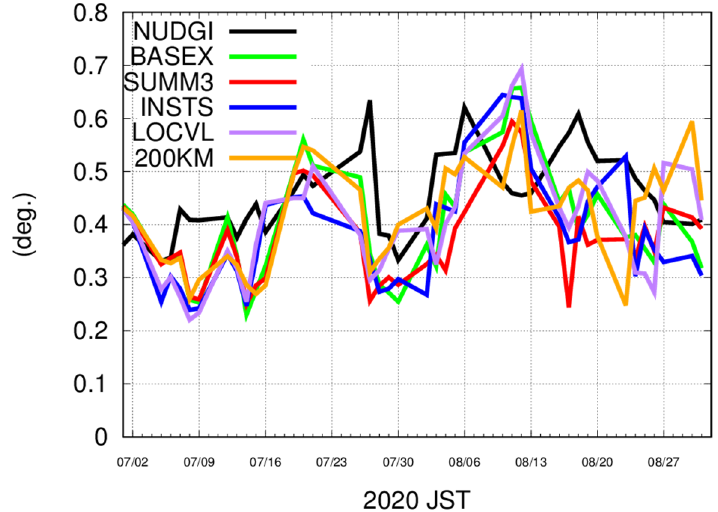
Figure 5. Time sequences of daily latitudinal RMSD (in degrees) between the modeled (six cases) and observed Kuroshio axis positions in a longitudinal range of 130° E–140° E. The modeled Kuroshio axis positions were defined as the closest locations to the observed ones with daily mean SSH = 0.3 m. Table 2. Minimum values of regionally calculated daily correlation between modeled and ob- served SST (